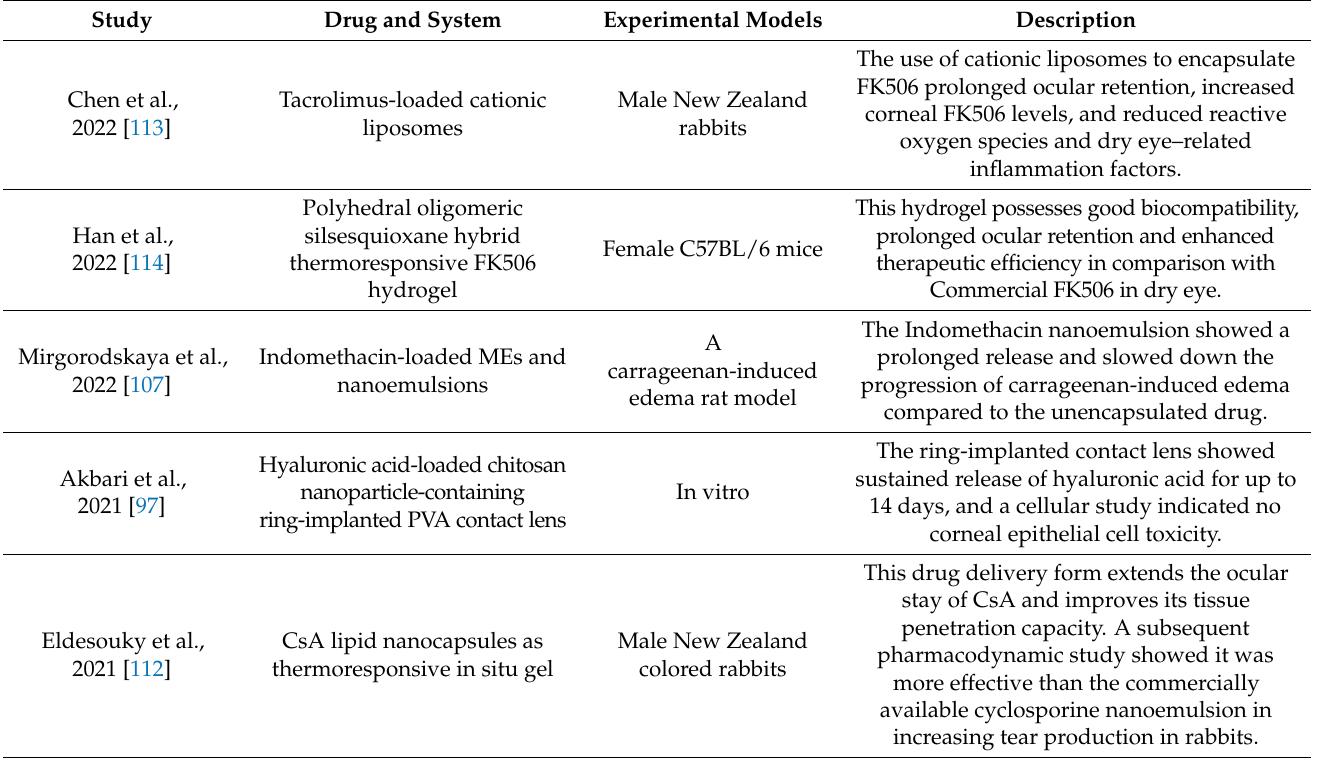
Table 1. Studies of biodegradable formulations for anterior segment